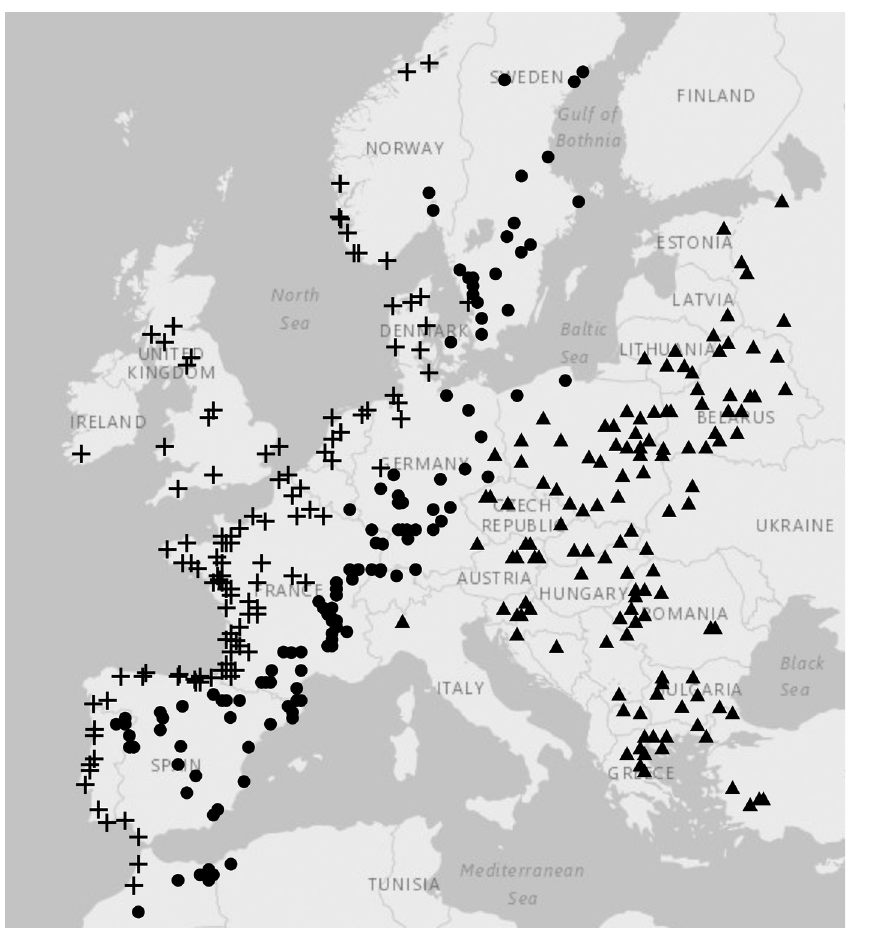
Figure 3. Map displaying